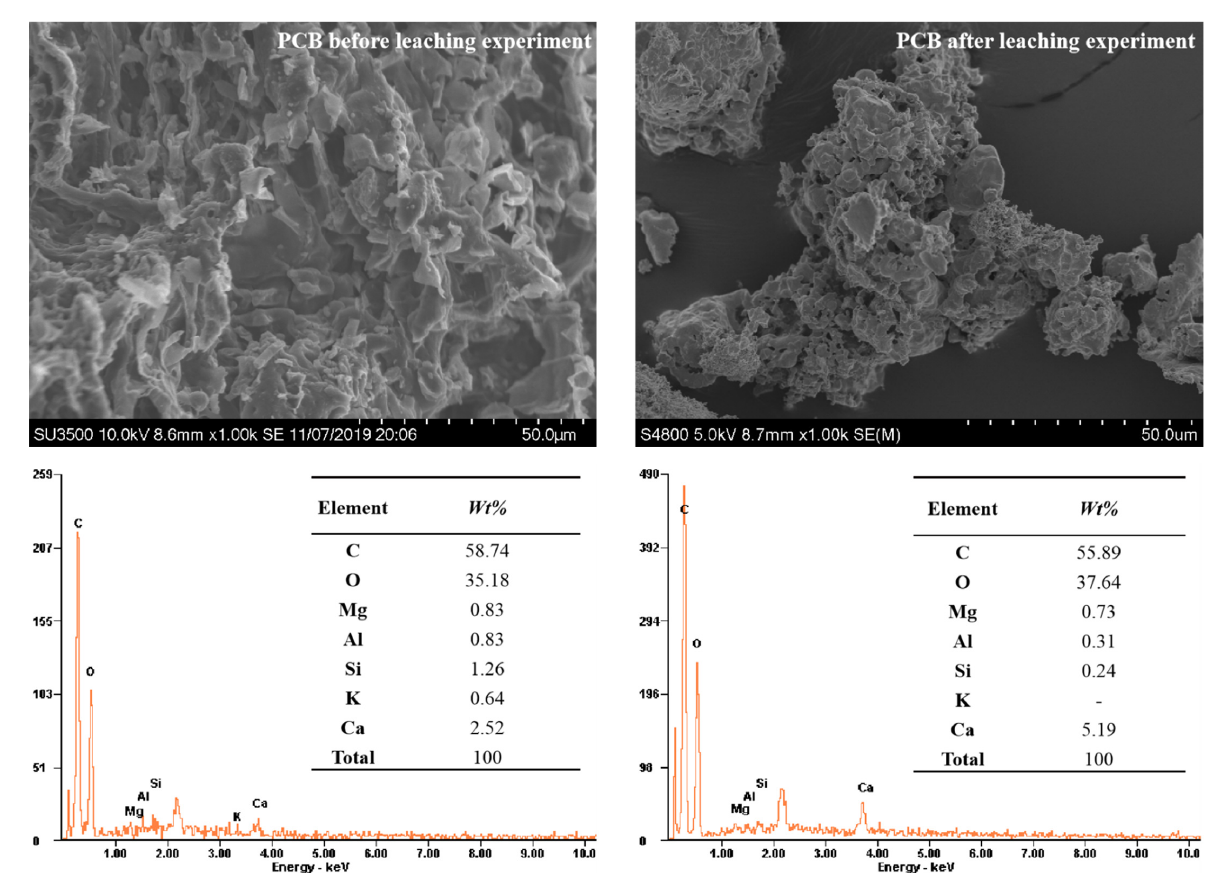
Figure 2. The scanning electron microscopy (SEM) and energy dispersive spectroscopy (EDS) results of polyurethane– biochar crosslinked material (PCB) before and after leaching experiments.